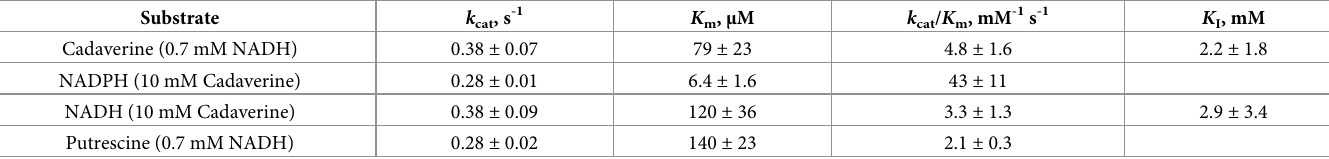
Table 1. Steady-state kinetic parameters determined in NAD(P)H oxidation assays for different substrates. Substrate k cat , s -1 K m , μ M k cat / K m , mM -1 s -1 K I , mM Cadaverine (0.7 mM NADH) NADPH (10 mM Cadaverine) 0.28 ± 0.01 NADH (10 mM Cadaverine) 0.38 ± 0.09 Putrescine (0.7 mM NADH) 0.28 ± 0.02 Initial rates measured with varied concentrations of cadaverine or putrescine (or 10 mM) in NAD(P)H oxidation assays in the presence of Ss DesB, 50 μ M FAD, and 0.7 mM NAD(P)H (or varied concentrations). All measurements were made in